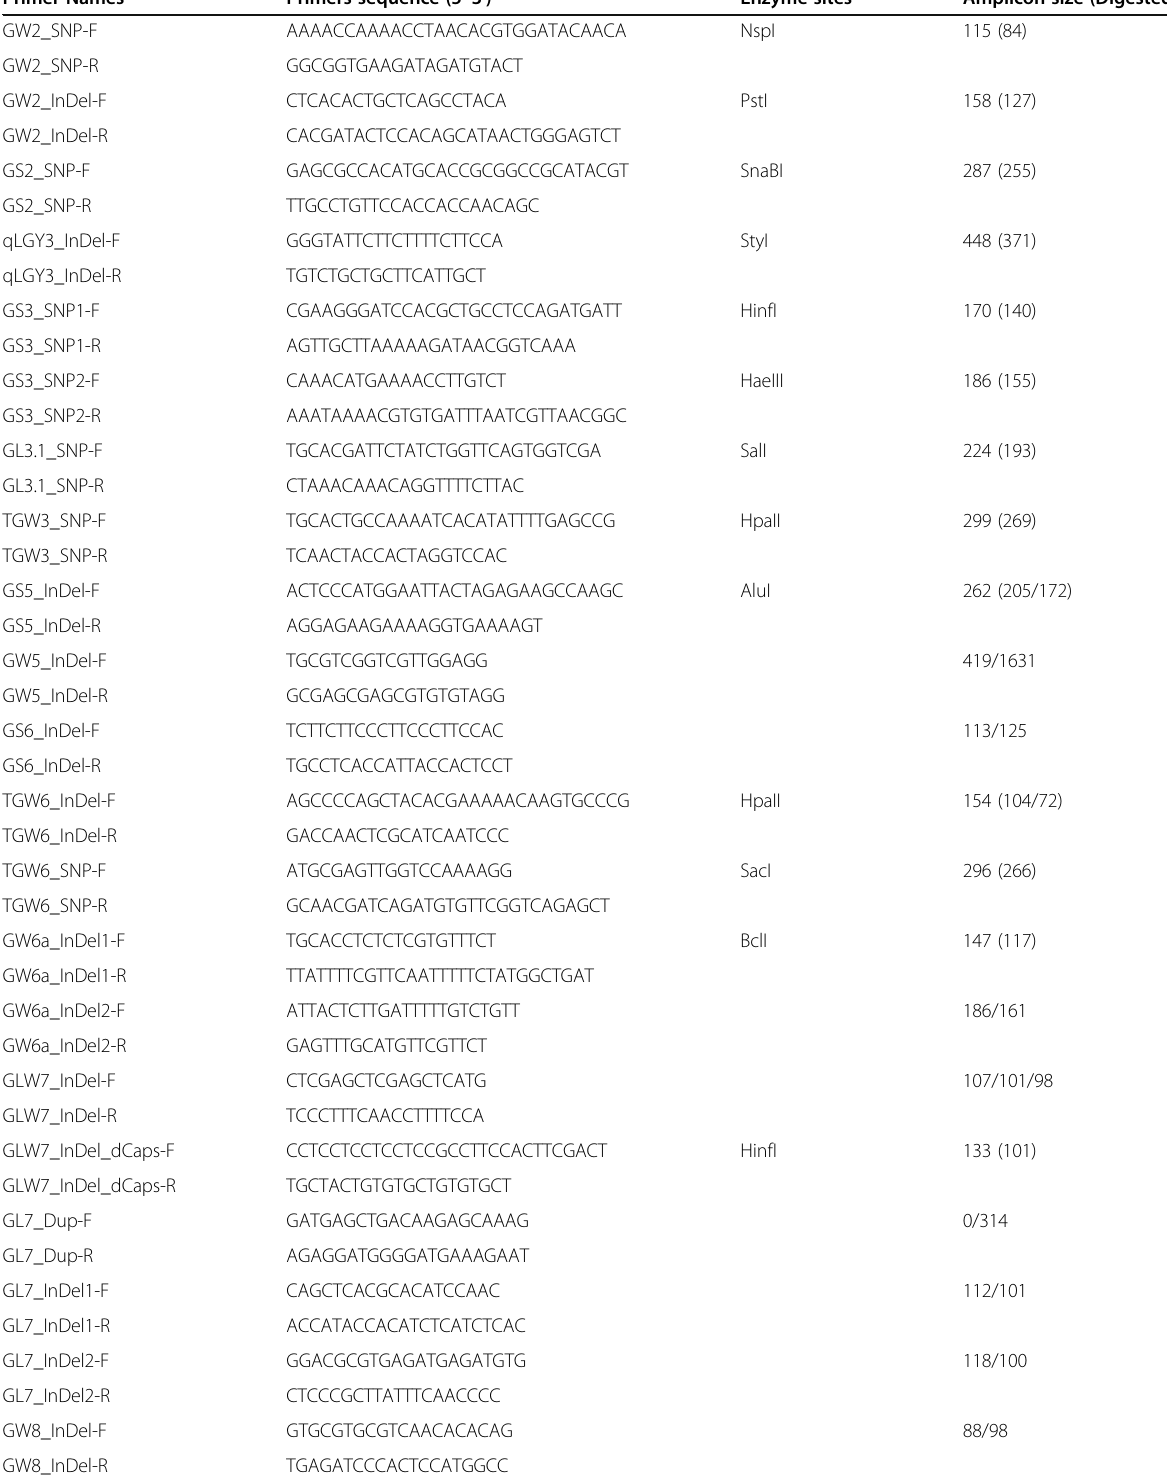
Table 1 Primer information on the 21 functional markers targeting 14 grain size